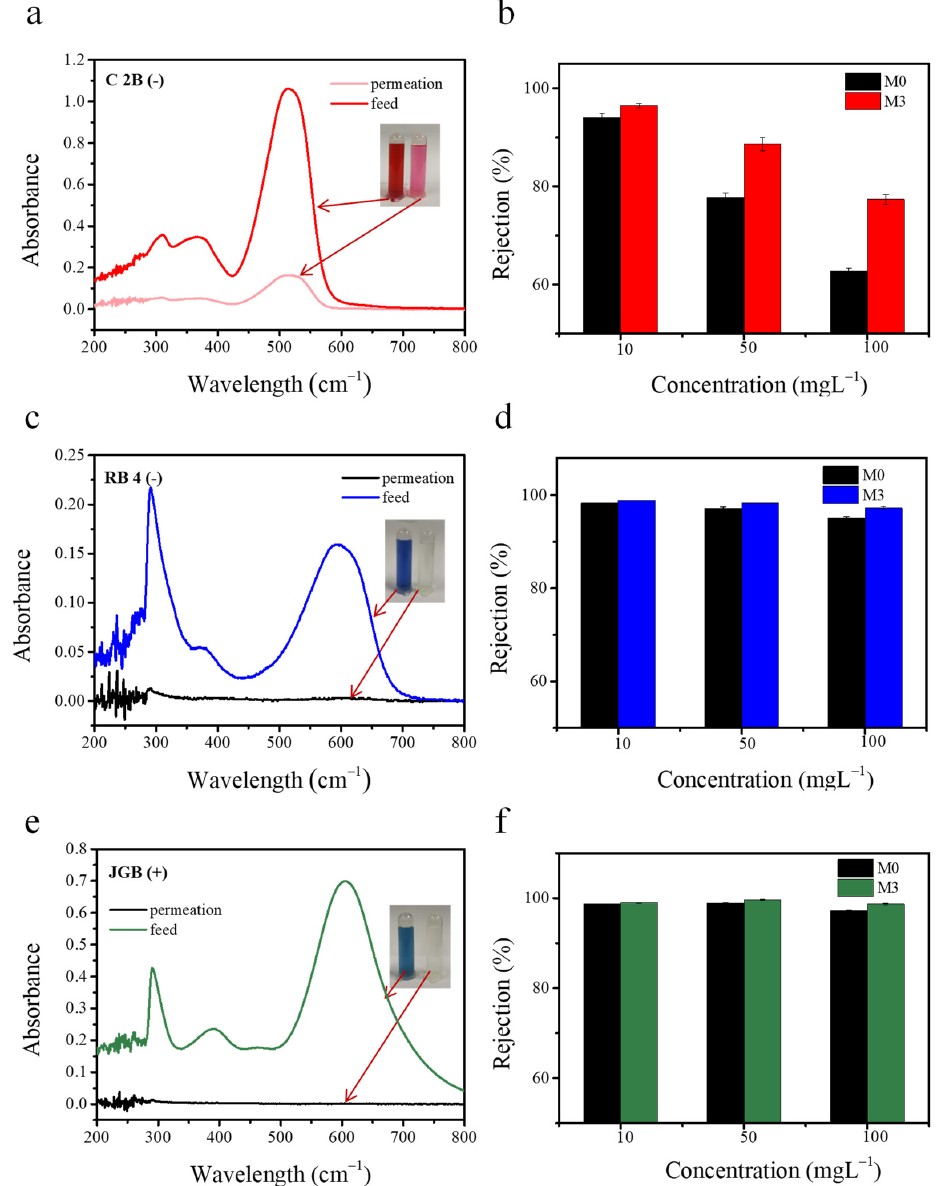
Figure 10. UV-vis absorbtion spectra of the feeds and the permeation of dyes for membrane M3: Chromotrope 2B (C2B) ( a ), Reactive Blue 4 (RB4) ( c ), and Janus Green B (JGB) ( e ). The insets are the corresponding photographs of the dye solutions before and after filtration. Rejection of M0 and M3 membrane for different concentrations of dyes C2B ( b ), RB4 ( d ), and JGB ( f ).